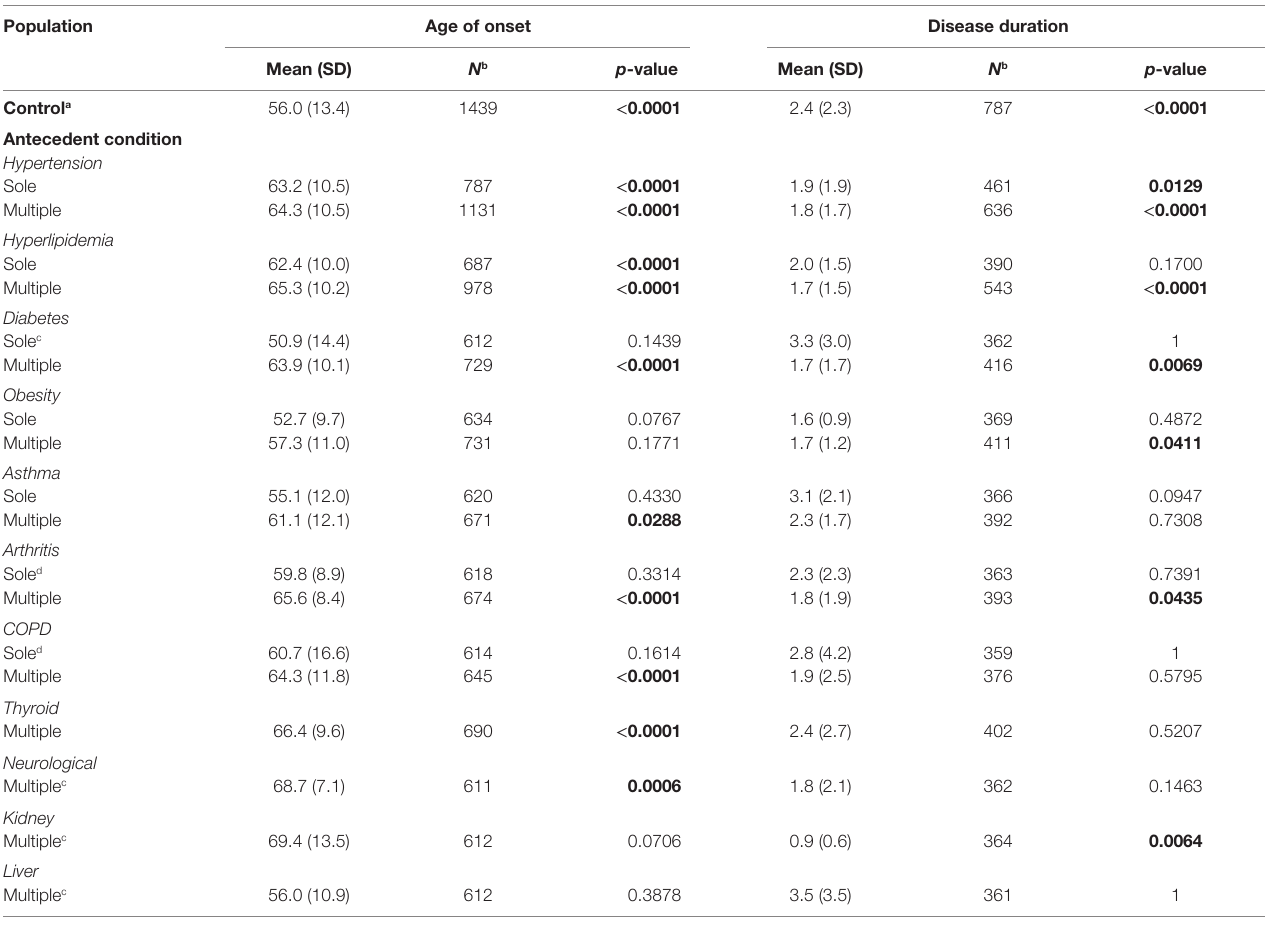
Chi square analysis with population distribution above or below the mean of the total population (60.1 for age of onset and 2.12 for disease duration). Mean (SD) is in years, represents age of onset or disease duration. Bold represents statistical significance. a Control population compared to any antecedent condition population.